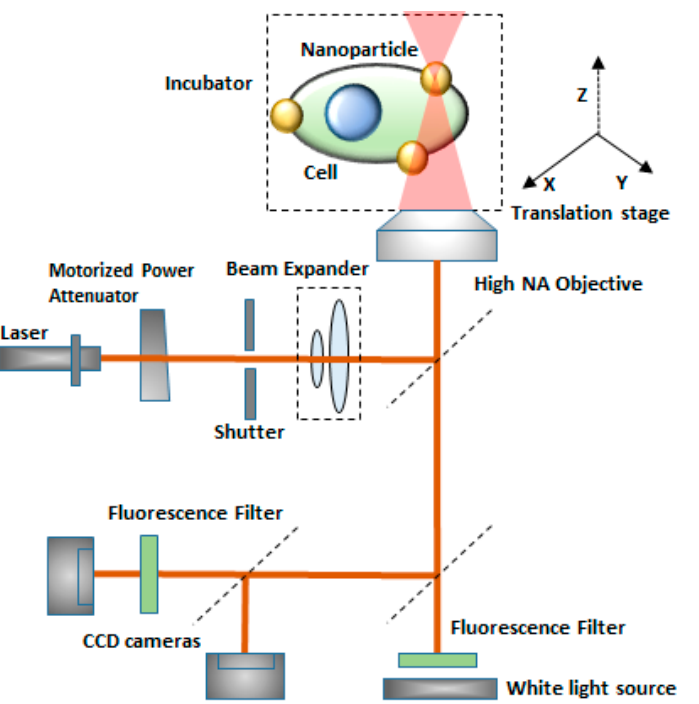
Figure 21. Schematic representation of the Nano blade. The figure depicts the process of cell mem- brane pore formation by creating microbubbles. Reprinted with permission from ref. [146]. Copy- right © 2010 Optical Society of America.